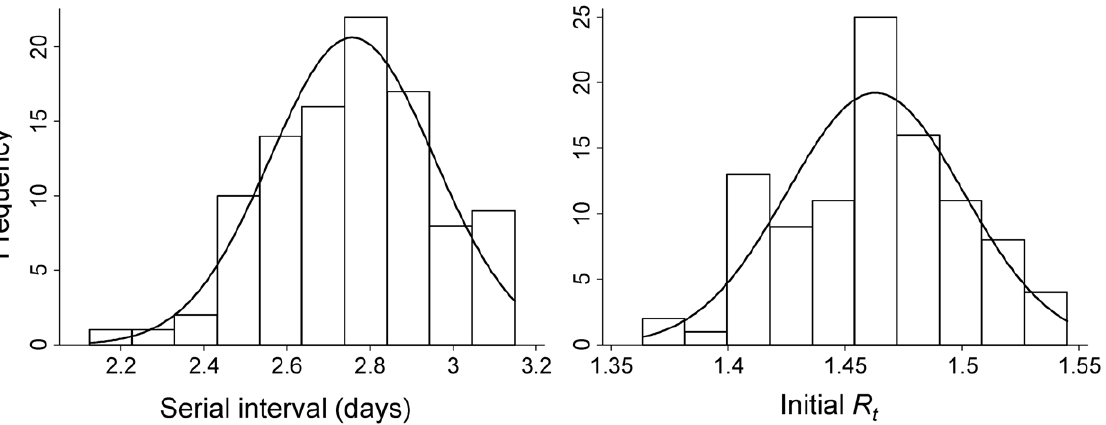
Figure 2. Distribution of serial interval and initial effective reproductive number ( R t ) across 100 simulations for the influenza A(H1N1)pdm09 epidemic in South Africa using the likelihood-based simultaneous estimation method (method 1).